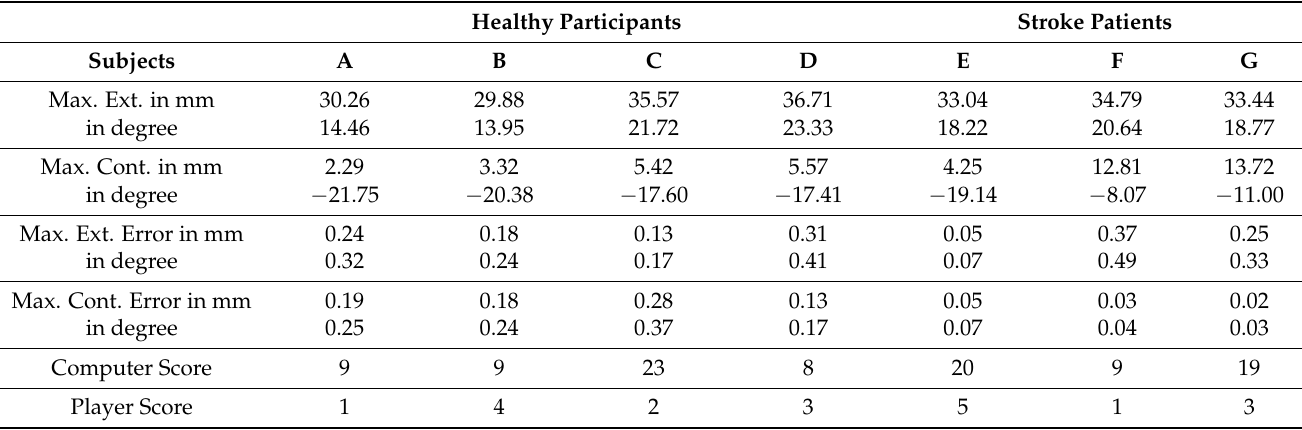
Table 1. Actuator response and final game score.